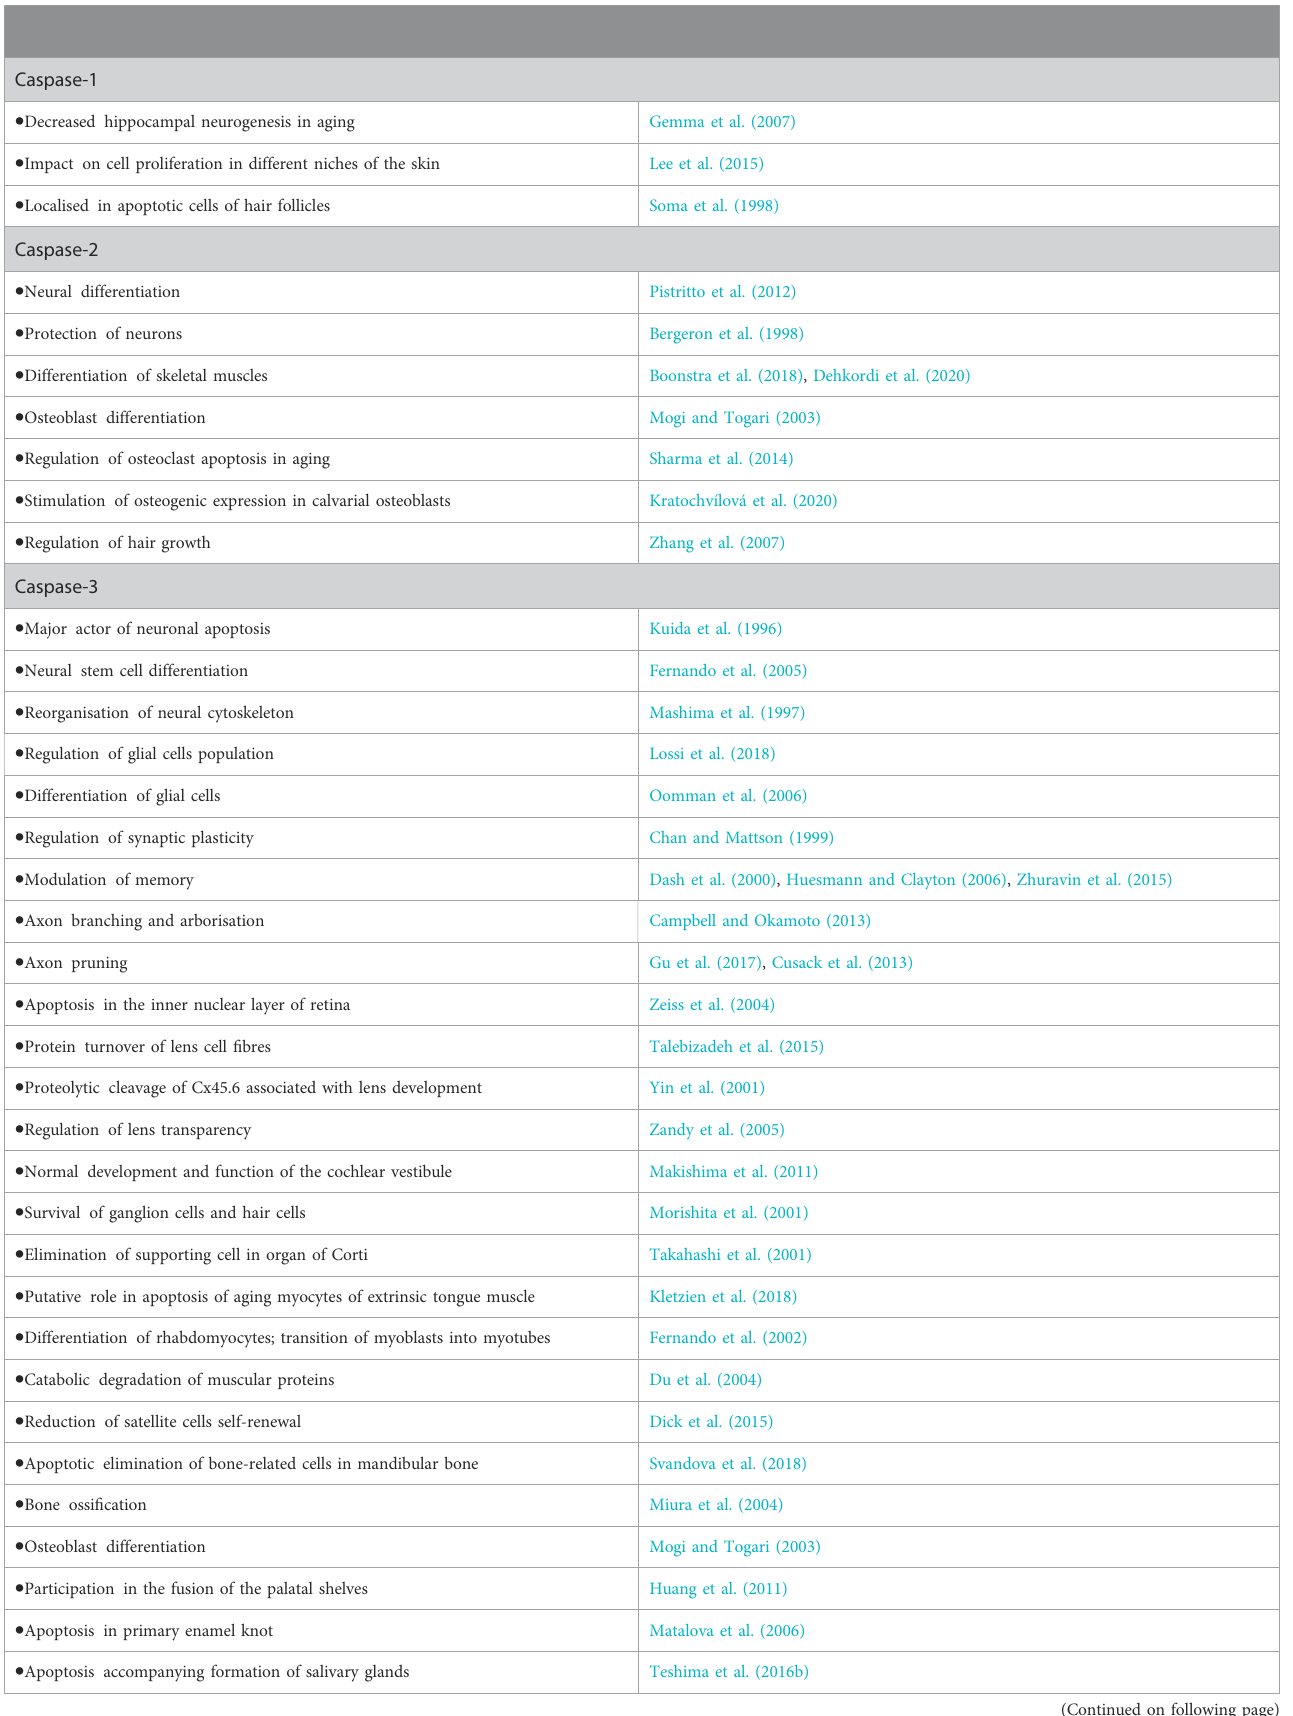
TABLE 4 Overview of participation of caspases and their functions in development of the head